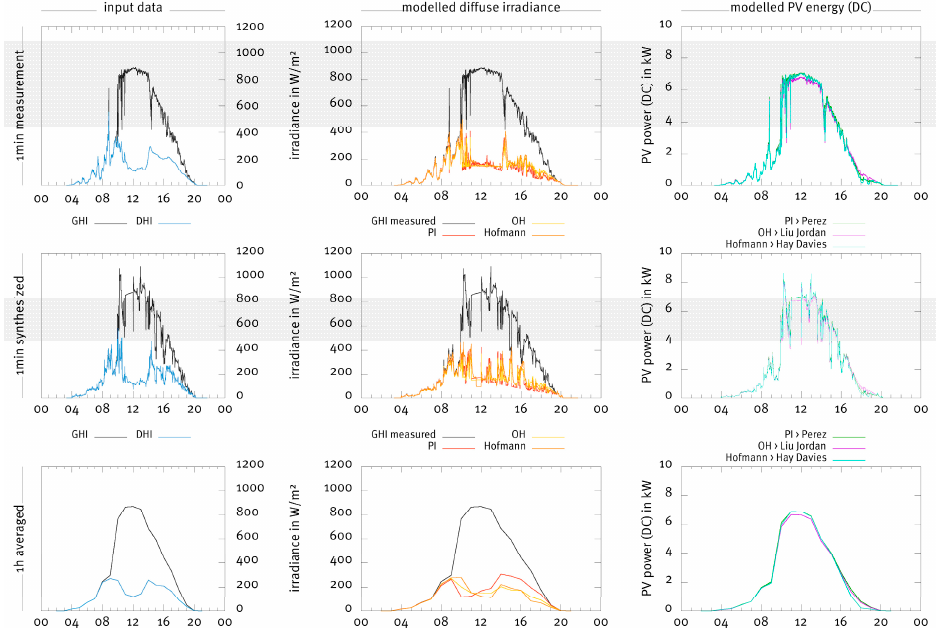
Figure 2. Simplified example of the matrix simulations for one day (5 June 2003) and one location